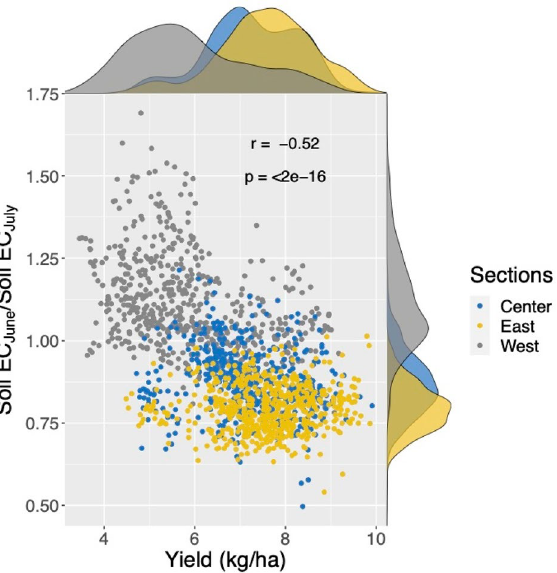
Figure 10. The negative correlation between crop yield (kg/ha) and the ratio of soil ECa of June and July shows the decrease in crop yield corresponding to the decrease in soil moisture in the west area.